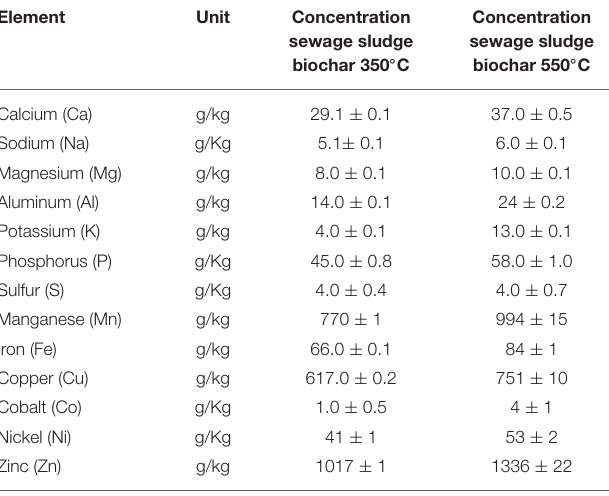
TABLE 6 | Total element composition of sewage sludge biochars produced at 350 and 550 ◦ C using wet acid-extract method followed by ICP-OES in accordance with EPA method 3050B ( n = 3) *